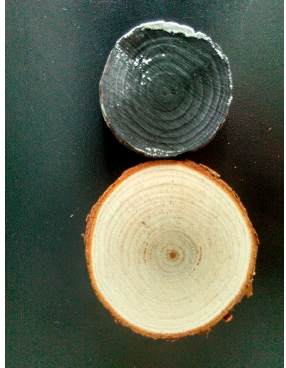
Figure 12. Evaporation rates of LiCl solution with solar steam structure material (30 mL).